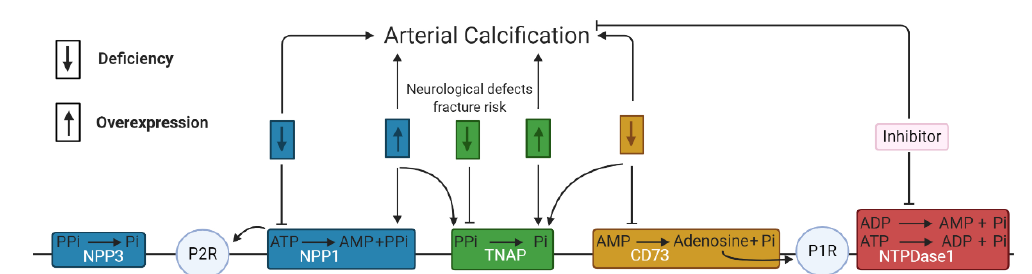
Figure 3. The reciprocal interaction between the different ecto-nucleotidases. The downward and upward arrow represents, respectively, a deficiency and overexpression of the ecto-nucleotidase activity. ( Blue ) NPP1 and NPP3 are involved in the synthesis and hydrolysis of pyrophosphate (PP i ). Either a deficiency or overexpression of NPP1 activity leads to arterial calcification, as well as overexpression of NPP1 favoring TNAP activity and inducing less ATP mediated purinergic receptor 2 signaling (P2R). ( Green ) A deficiency of TNAP activity is linked to neurological defects and fracture risk by decreased P i generation, while overexpression of TNAP activity favors arterial calcification through a reduction in PP i . ( Orange ) A deficiency of CD73 or 5′-nucleotidase triggers arterial calcification by promoting TNAP activity and reducing the production of adenosine and thus less adenosine mediated P1R signaling. ( Red ) Inhibition of NTPDase 1 reduces arterial calcification by diminishing P i generation. This scheme is based on the results in multiple cell types including VSMCs, VICs and endothelial cells but also i.e., primary dermal fibroblasts from arterial calcifications due to deficiency of 5′-nucleotidase/CD73 (ACDC) patients.